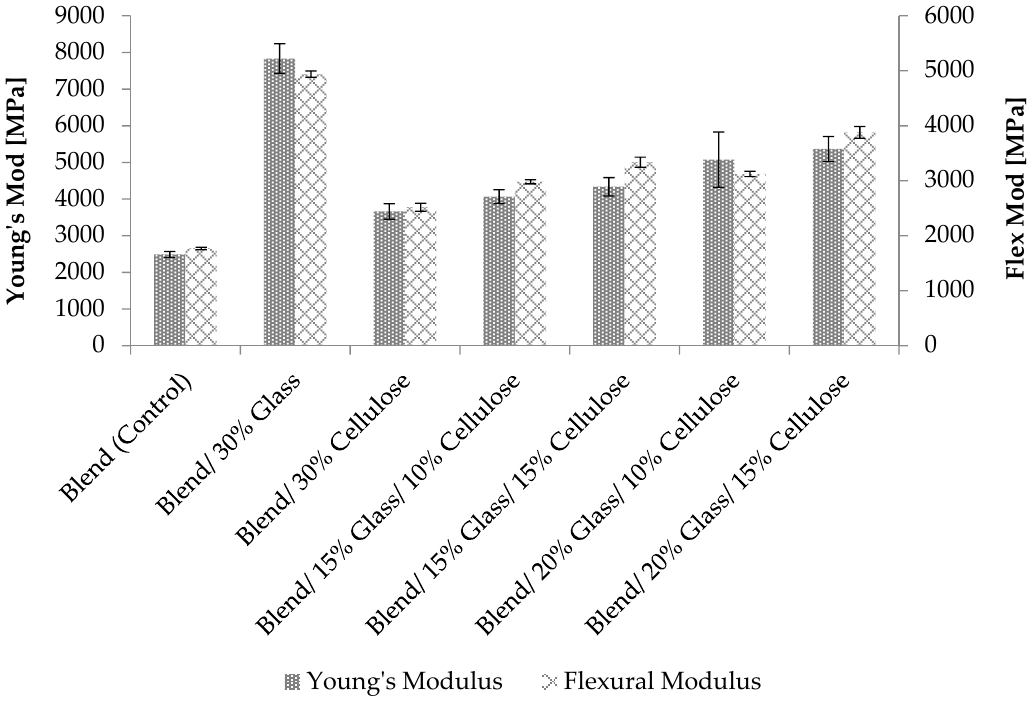
Figure 3. Young’s modulus and flexural modulus of unfilled polymer blends and cellulose and glass fiber reinforced composites.